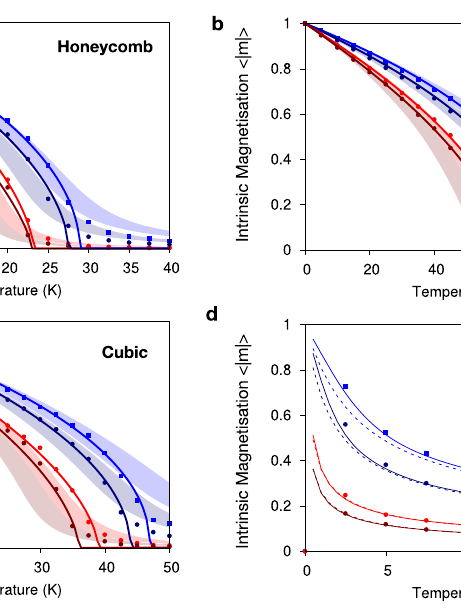
temperature arising from the mean- fi eld approximation. See Supplementary Sec- tion 6 for details. The dashed and solidlines in d indicate the anisotropicspherical model calculations, and the exact solution, respectively. Both show a sound agreement with the atomistic simulations. The datasets in a – c clearly show the existenceofshort-rangecollinearmagneticorderforall2Dlatticesatthesimulated sizesconsideredwithnonzerocrossovertemperature.Zeromagneticanisotropyis included in all